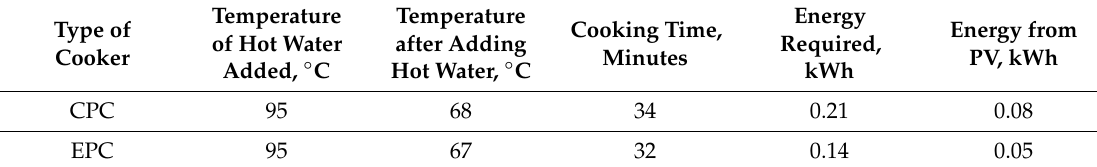
Table 7. Chickpea cooking using pressure cooker with hot water added from the water